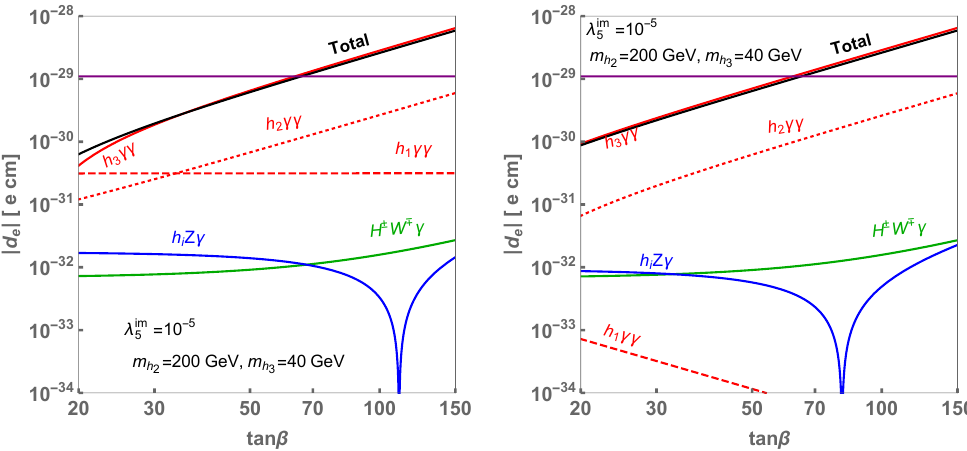
Figure 2 . Absolute contribution on electron EDM coming from di(cid:11)erent Barr-Zee diagrams as a function of tan (cid:12) . We have (cid:12)xed m h panel we plot the RS scenario which corresponds to cos( (cid:12) WS scenario with cos( (cid:12)